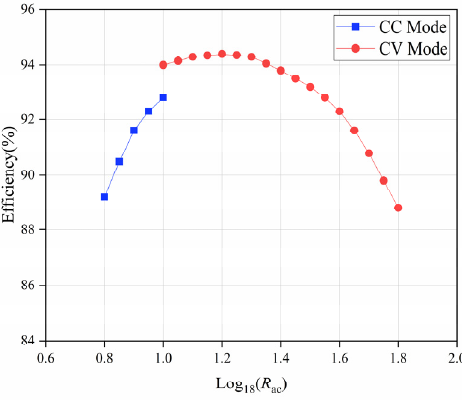
Figure 15. The efficiency of the proposed LC/S compensated IPT system throughout the charging process.